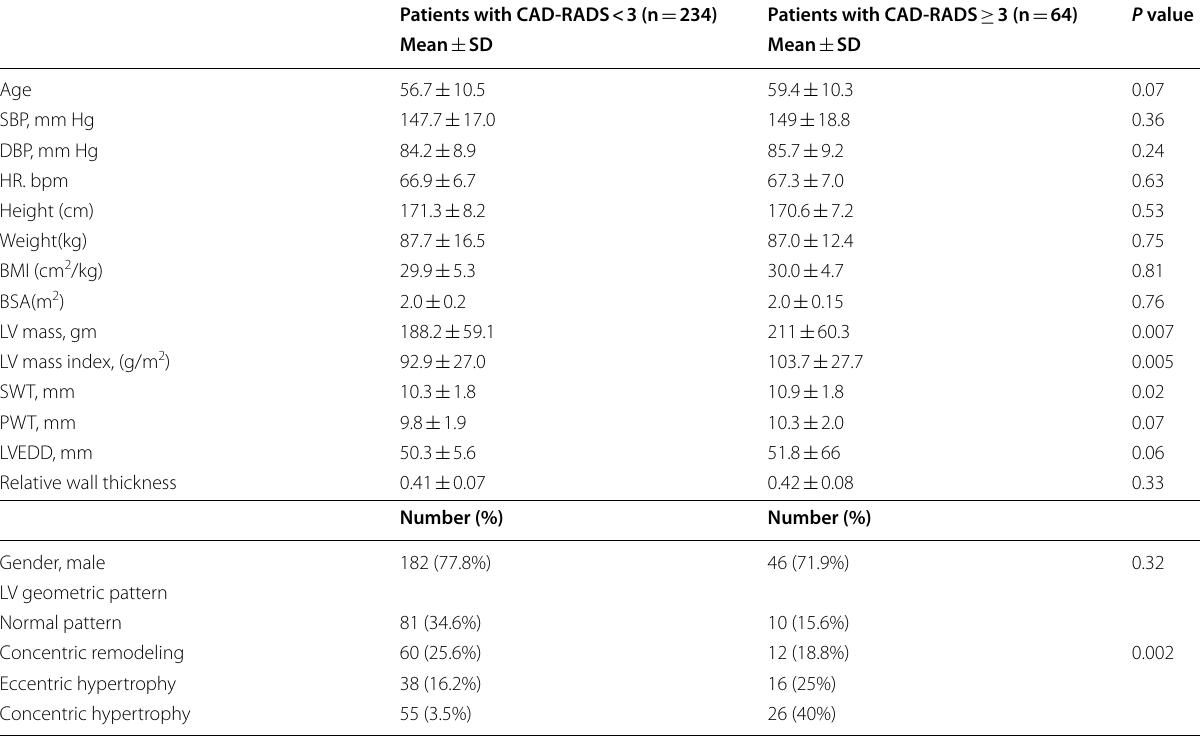
Table 5 Comparison between patients with CAD-RADS < 3 and those with CAD-RADS